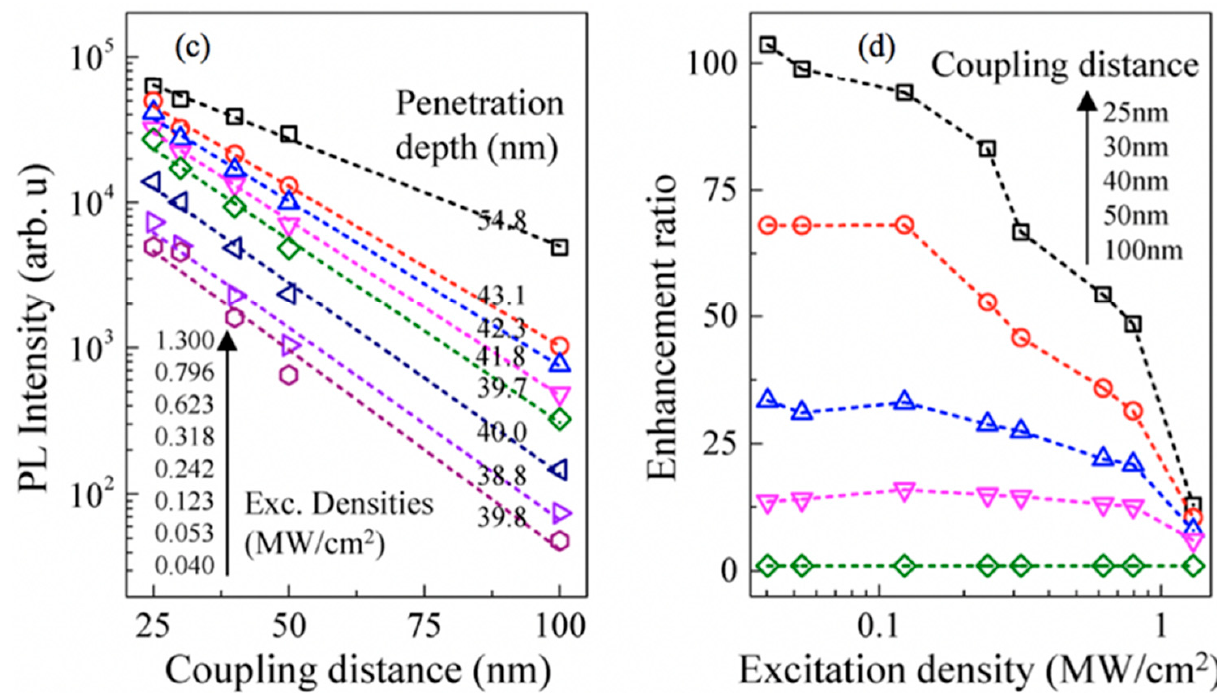
Figure 2. ( a ) Schematic diagram representing the basic structure of the SP-enhanced LED, ( b ) the plane-view SEM image of AgNPs inside the microcave, inset: diameter distribution of AgNPs, ( c ) the excitation power-dependent near-field PL vs. position of AgNPs in one of the SP-enhanced LEDs used in the study, and ( d ) the corresponding enhancement vs. excitation power of AgNPs for the same device at different coupling distances. Reproduced from [74].